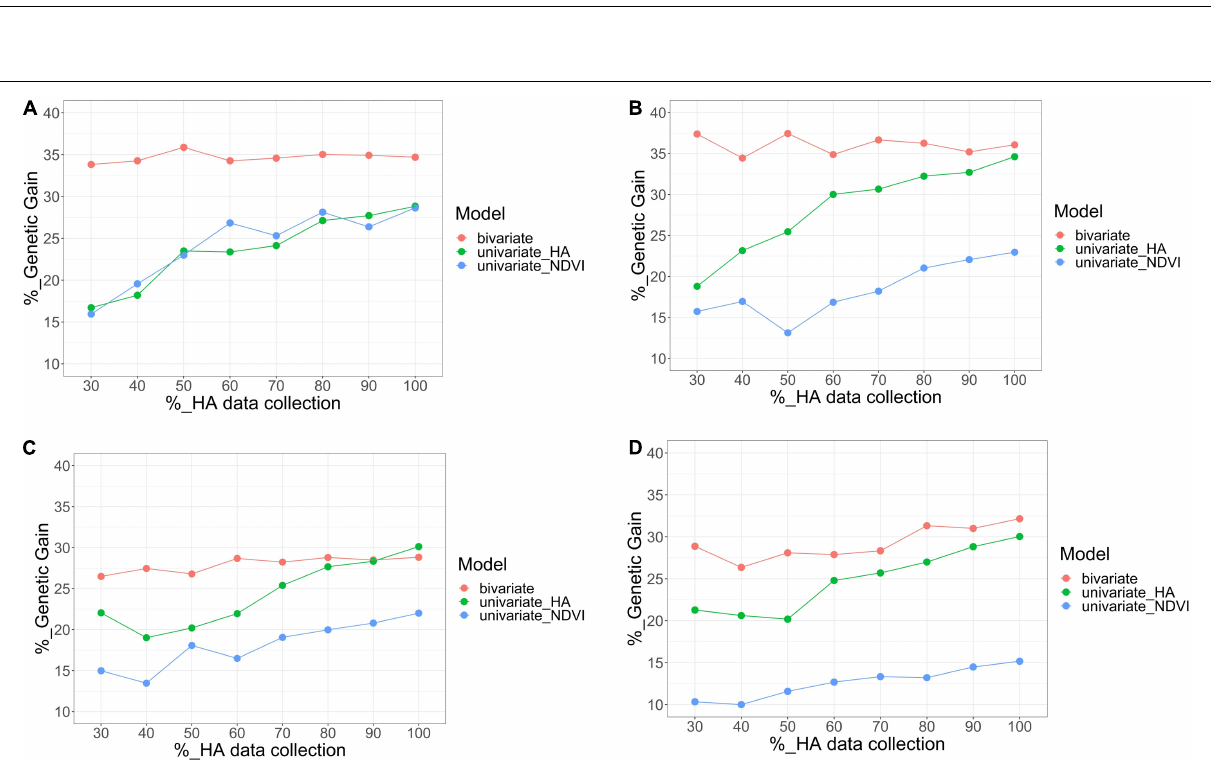
FIGURE 8 | Comparison of bivariate model (HA and NDVI, red), and univariate (HA, green; NDVI, blue) models for genetic gain for HA, after applying a 10% selection intensity for scenarios with increasing levels of HA data collection (30–100%) across four harvests in alfalfa families evaluated in Citra, FL, United States. Harvests one (A) , two (B) , three (C) , and four (D)